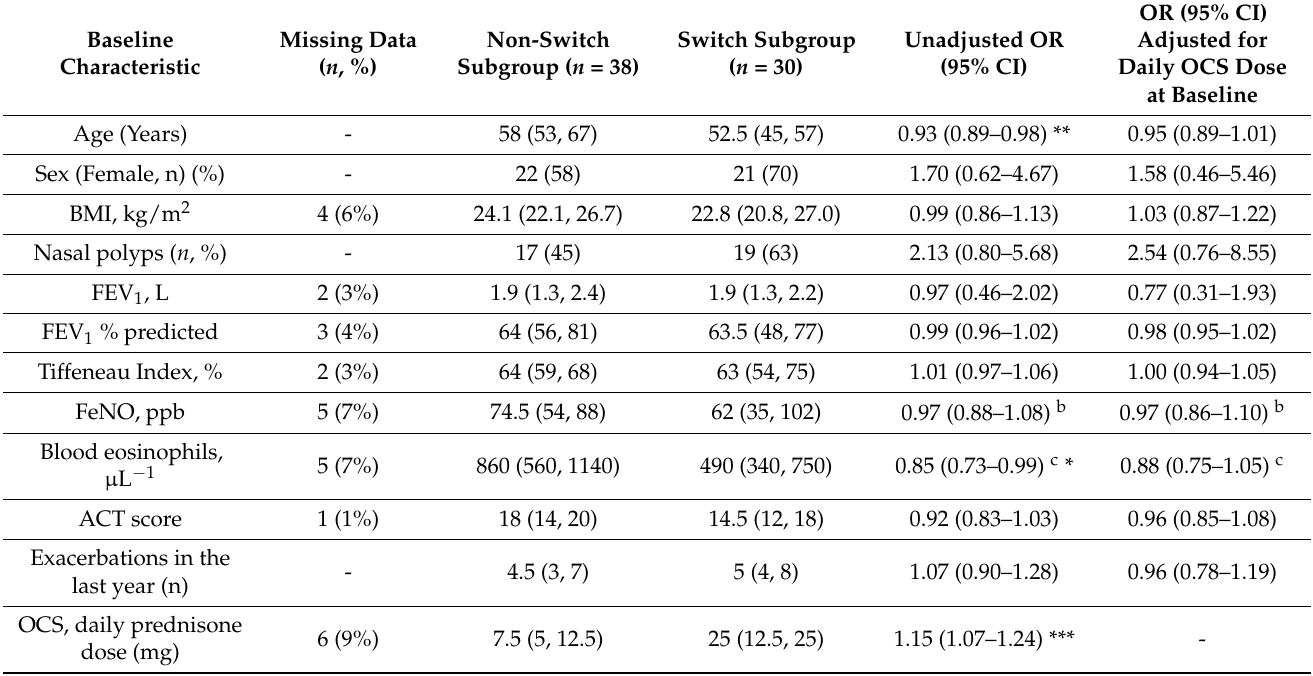
Table 1. Baseline characteristics of study population subgroups (non-switch/switch) and their association with the occurrence of switching a